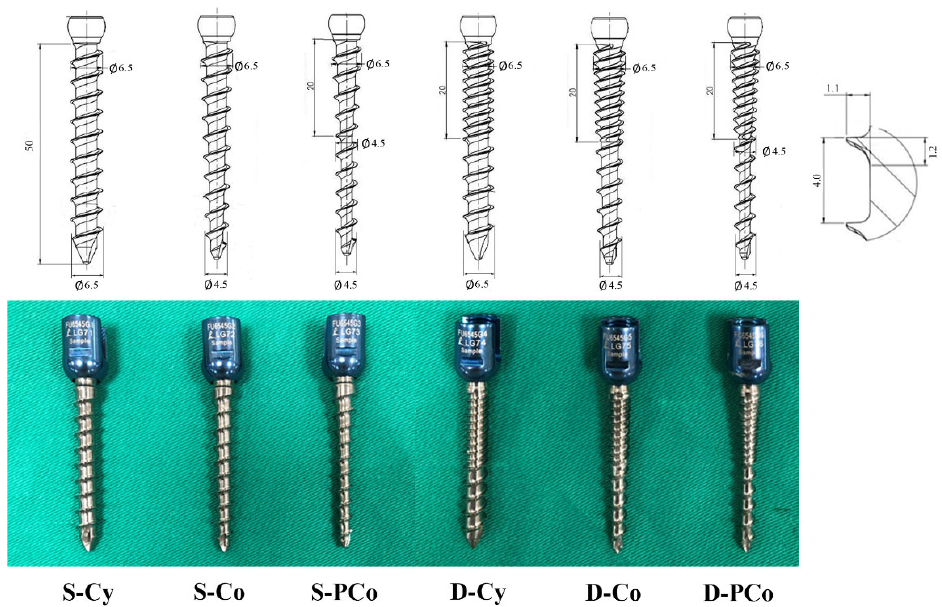
Figure 1. Schematic drawings ( upper ) and photographs ( lower ) of six types of pedicle screws with different thread profiles (single ‐ or dual ‐ thread) and projection shapes (cylindrical, conical, or prox ‐ imal ‐ conical shape). From left to right: single ‐ thread and cylindrical shape (S ‐ Cy), single ‐ thread and conical shape (S ‐ Co), single ‐ thread and proximal conical shape (S ‐ PCo), dual ‐ thread and cylindrical shape (D ‐ Cy), dual ‐ thread and conical shape (D ‐ Co), and dual ‐ thread and proximal ‐ conical shape (D ‐ PCo).